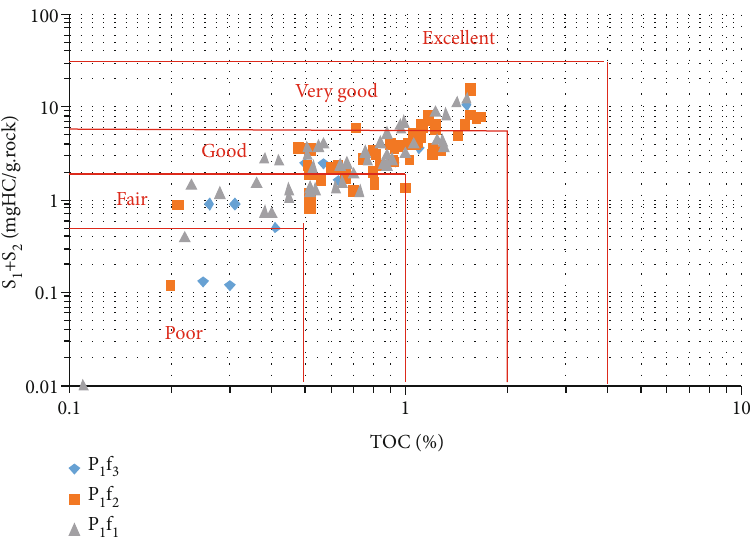
Figure 5: Quality classi fi cation of source rocks of the Fengcheng Formation shale in the Mahu Sag.